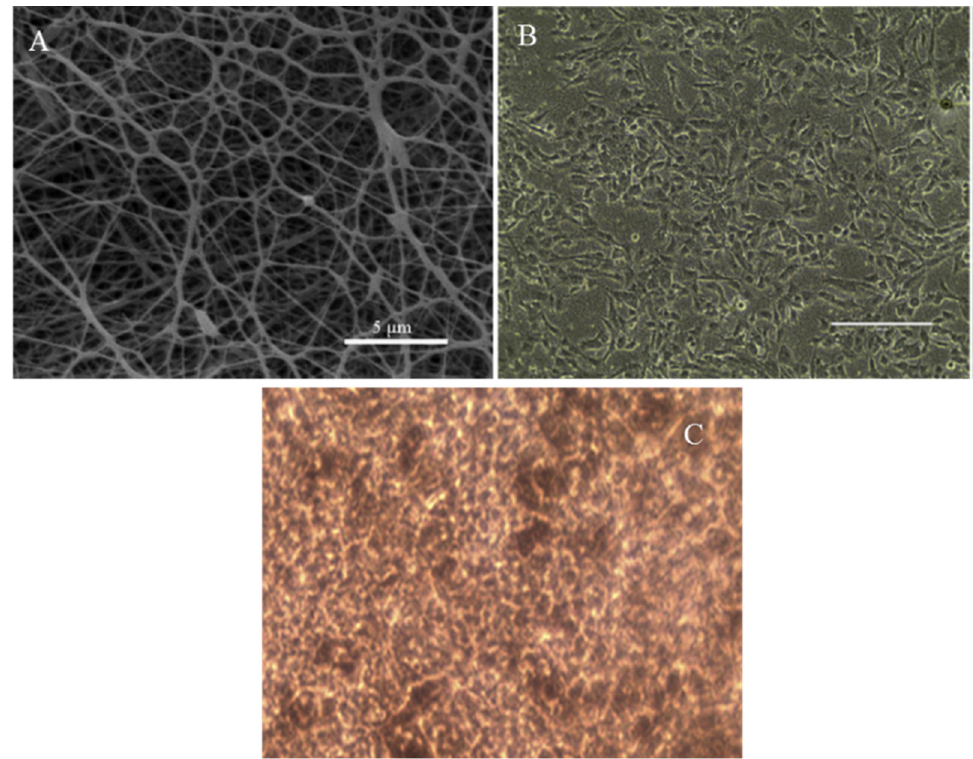
Figure 4. ( A ) SEM micrographs of PCL/RWSF/Gt. Scale bar = 100 μ m, ( B ) ARPE-19 cultured on PCL/RWSF/Gt membranes for 24 h and ( C ) establishment of long-term cultures of ARPE-19 cells on PCL/RWSF/Gt membranes in which ARPE-19 cells displayed much tighter junctions, smaller volume and melanin pigment appears in cells on 90th day. Reprinted from [80].